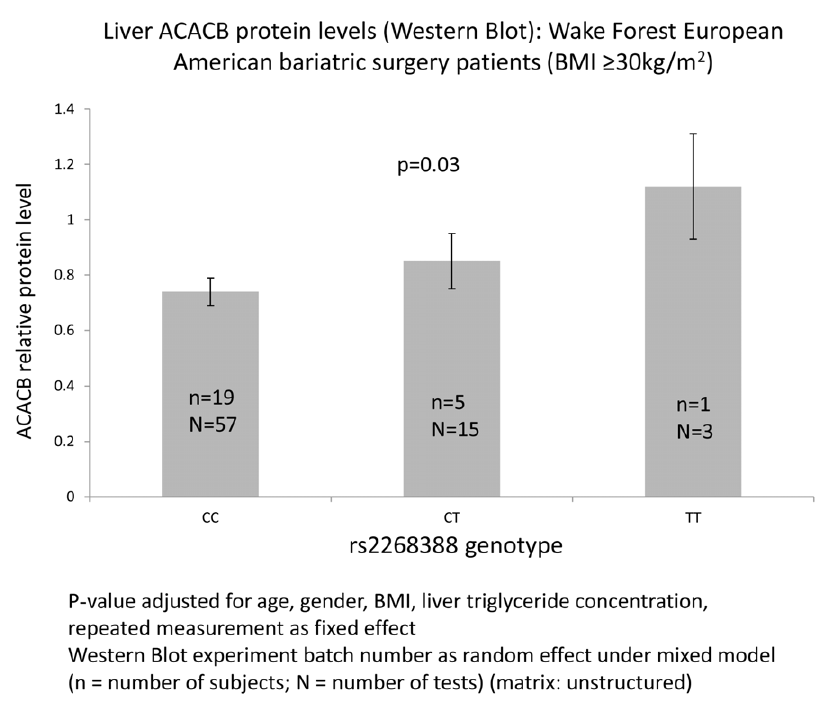
Figure 4. Liver ACACB expression by rs2268388.